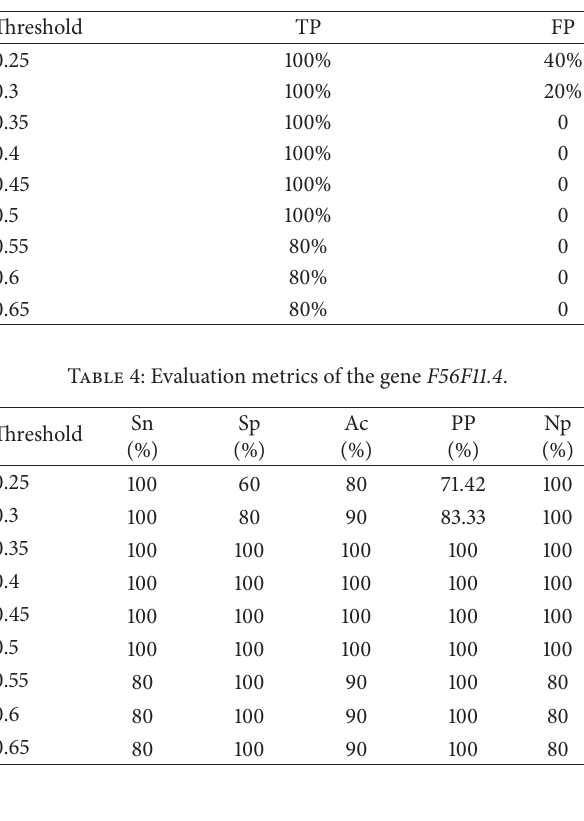
Figure 9: True Positive rate versus False Positive rate of the gene F56F11.4 . Table 3: Evaluation metrics of the gene F56F11.4 .